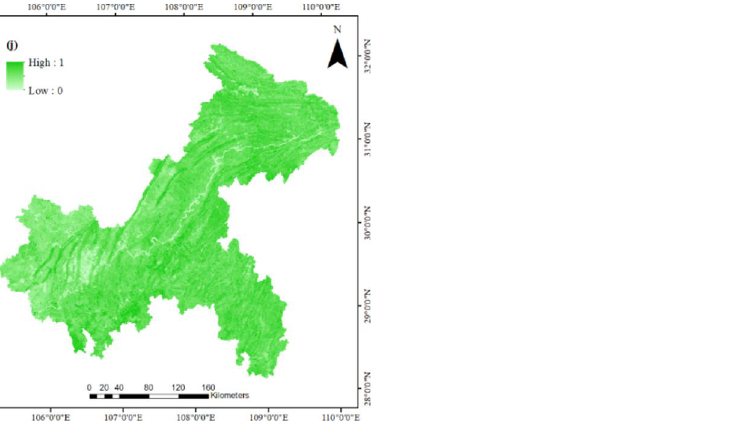
Figure A1. The distribution of vegetation cover. ( a ) 2000, ( b ) 2020, ( c ) Spring of 2000, ( d ) Spring of 2020, ( e ) Summer of 2000, ( f ) Summer of 2020, ( g ) Autumn of 2000, ( h ) Autumn of 2020, ( i ) Winter of 2000, ( j ) Winter of 2020.